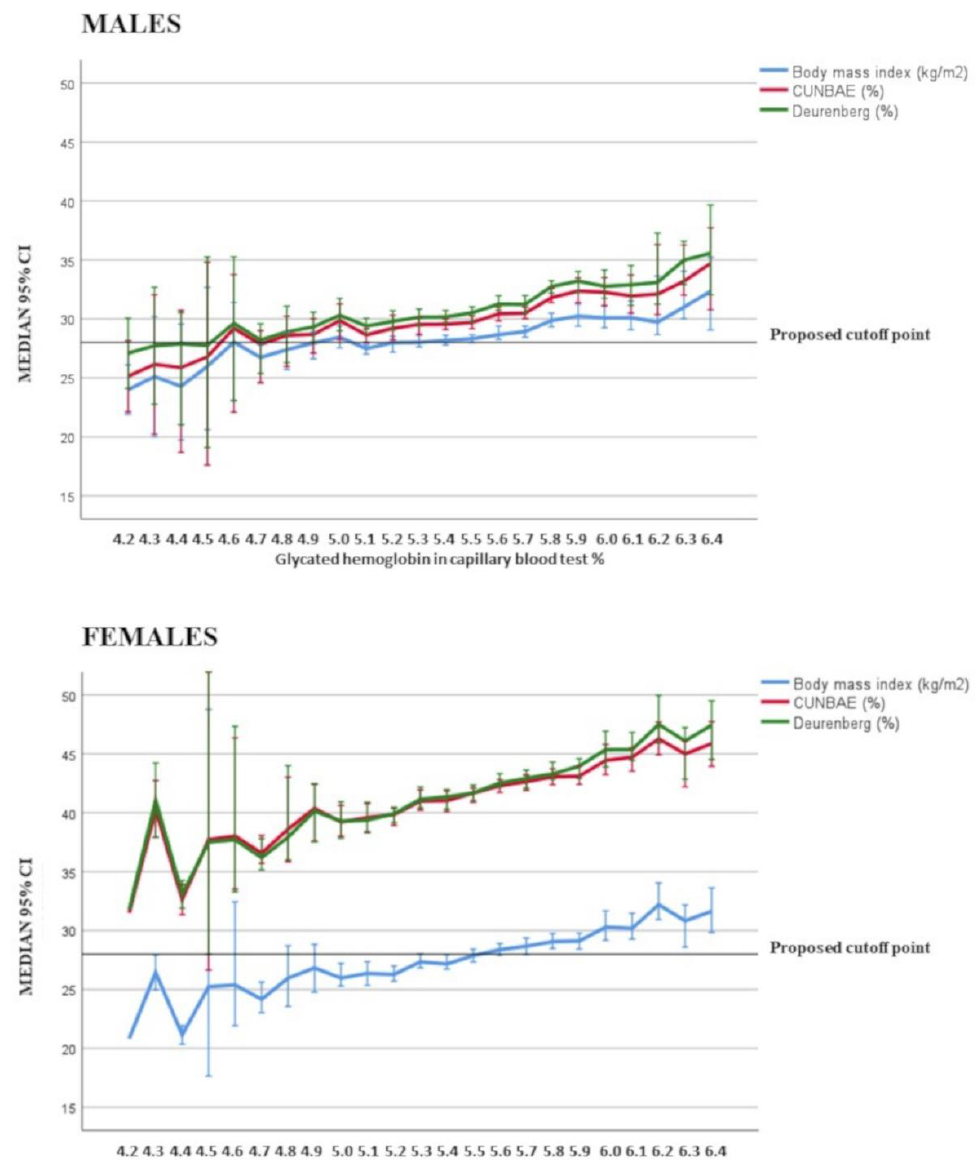
Figure 1. Results of the total adiposity indices in male and female individuals according to the level of glycated hemoglobin value. Table 4. Receiver Operating Characteristic curves and appropriate cutoff of anthropometric indices for predicting predi- abetes according to sex distribution.